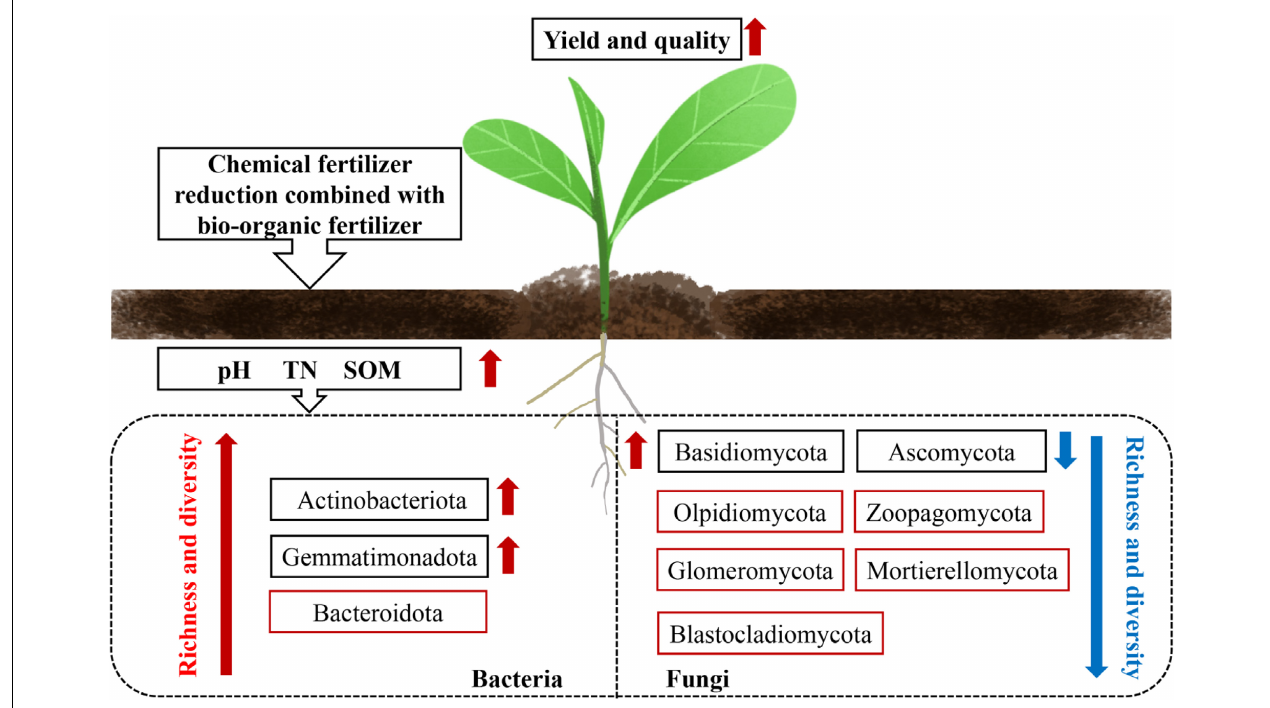
FIGURE 5 | Potential mechanism of action of reduced chemical fertilizer combined with bio-organic fertilizer in regulating soil microecology to improve the yield and quality of lettuce. The red arrow indicates an increase, and the blue arrow indicates a decrease. The red box indicates bacterial or fungal phyla with significant differences between